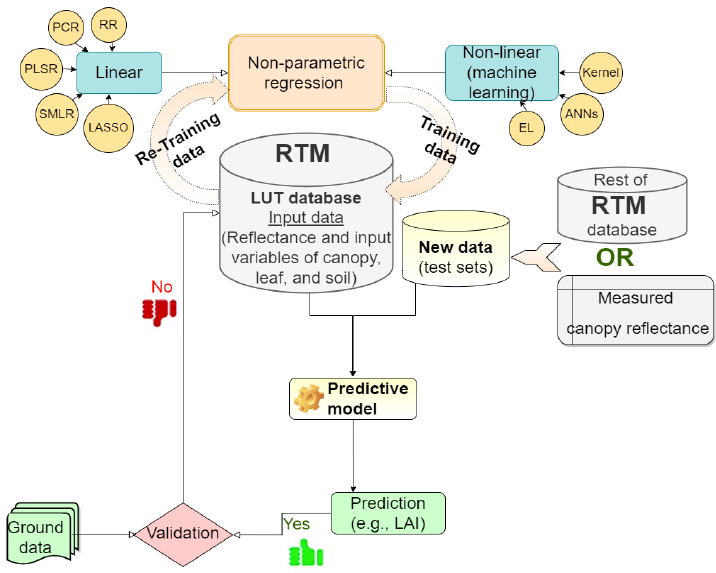
Figure 3. Flow chart of nonparametric algorithms process in the hybrid method. Table 2. Summary of the advantages and limitations and caveats of the nonparametric